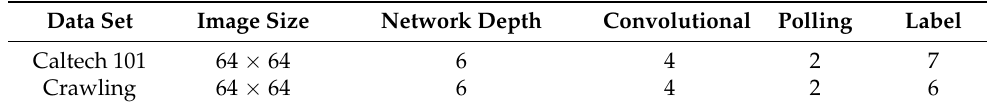
Table 5. Model Structure for CMP Performance Test.